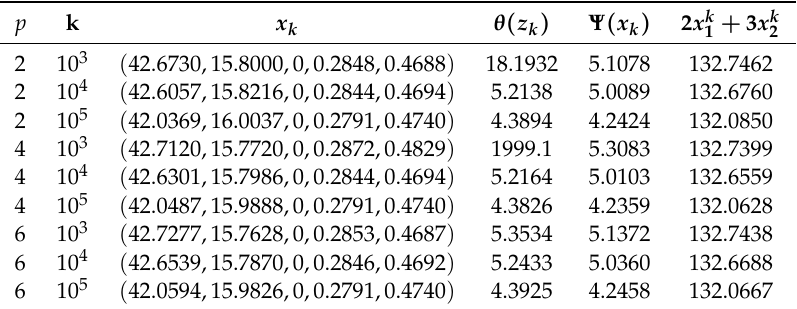
Table 5. Numerical results for Example 3 based on Condition 1.